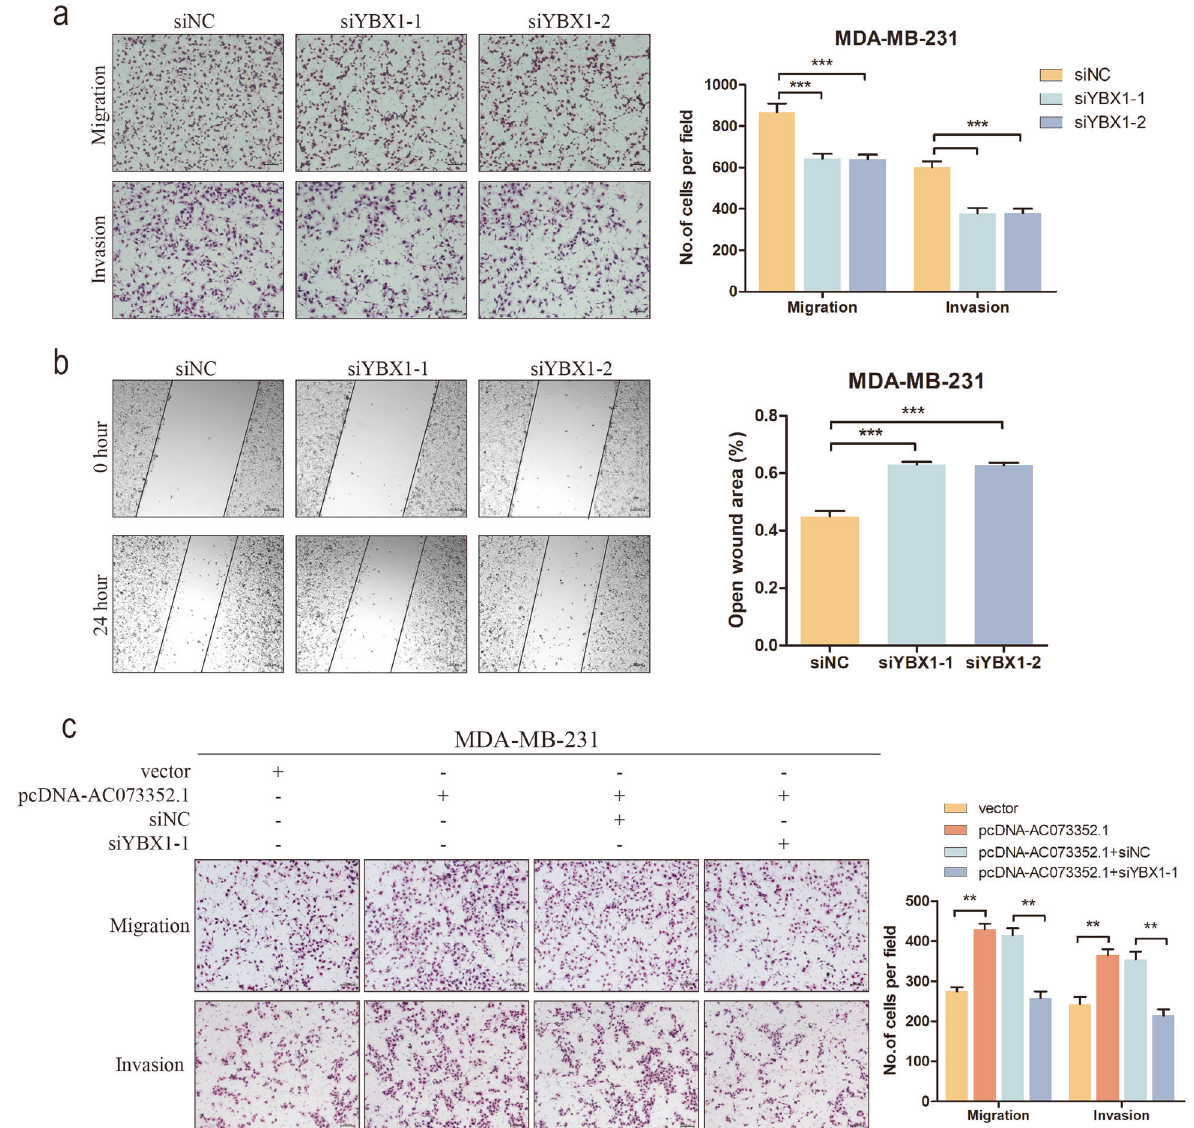
Fig. 6 AC073352.1 interacts with the transcriptional activator YBX1 to affect BC metastasis. a , b Transwell and wound-healing assays on MDA-MB-231 cells transfected with YBX1 siRNA. c Rescue assays following transwell assays revealed that the depletion of YBX1 partly reversed the effects of AC073352.1 overexpression in MDA-MB-231 cells. Values are expressed as mean ± SEM, n = 3. ** p < 0.01, *** p <